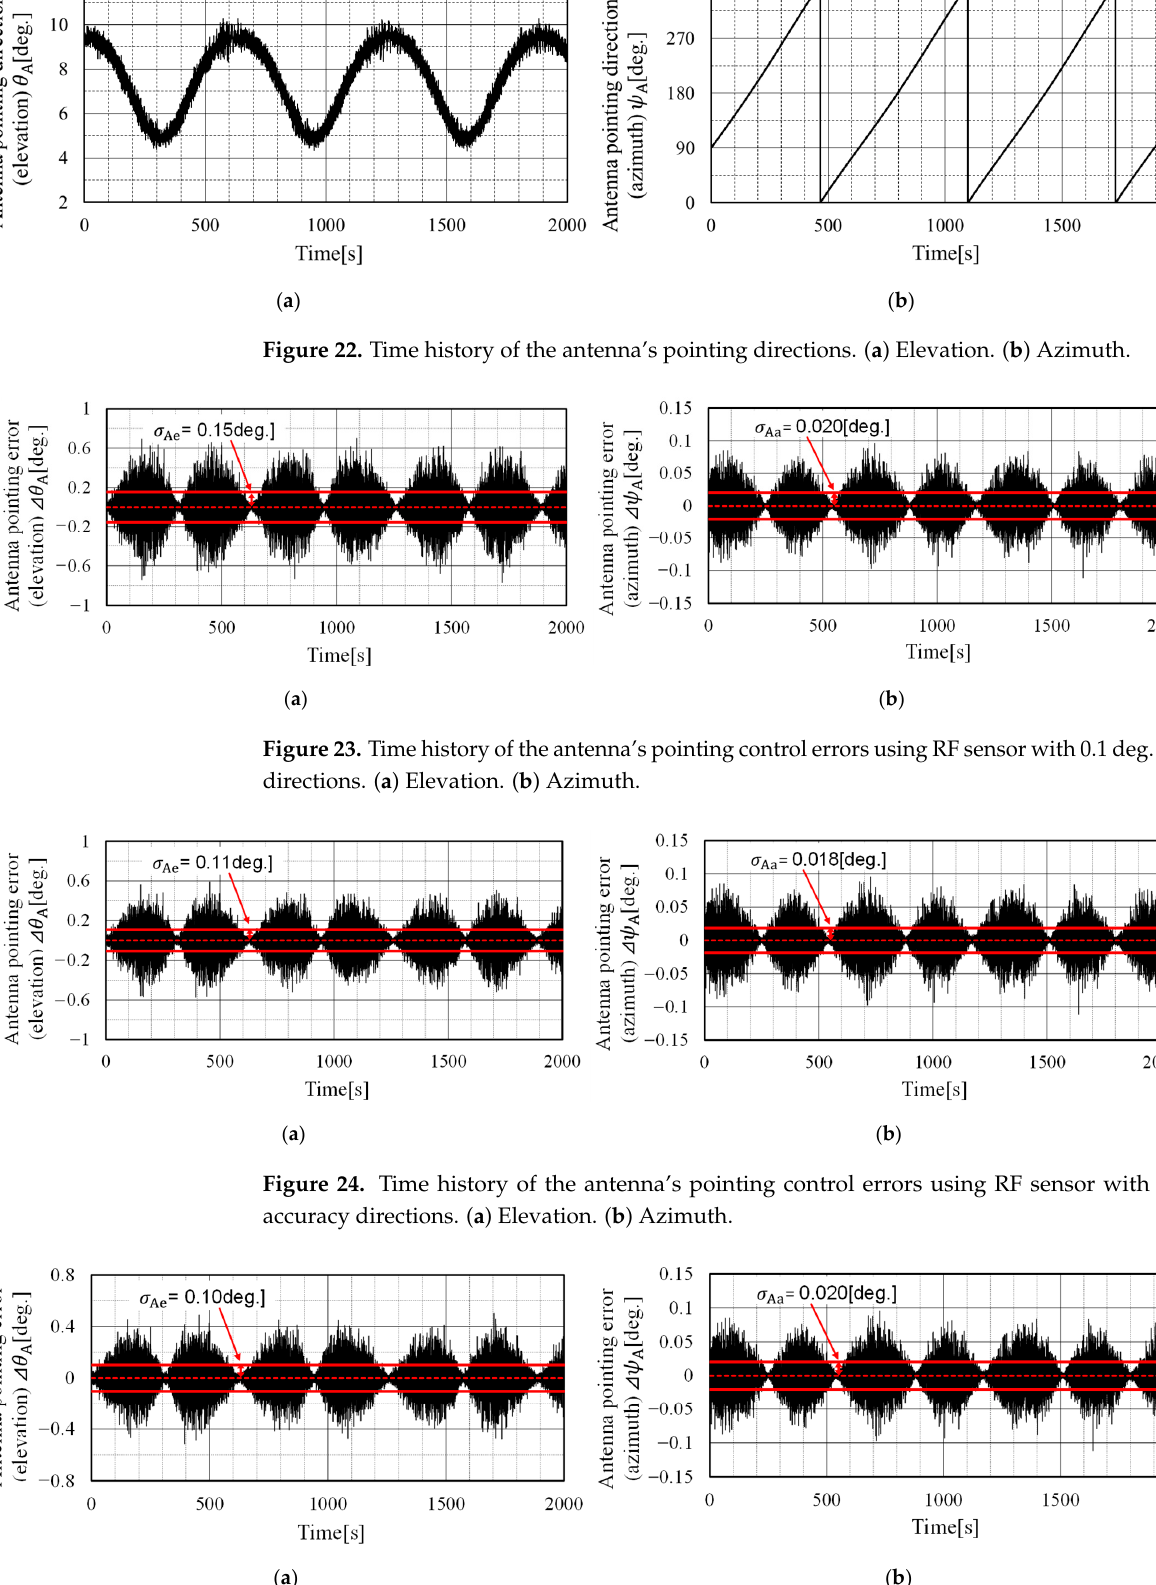
Figure 25. Time history of the antenna’s pointing control errors using RF sensor with 0.01 deg. ac- curacy directions. ( a ) Elevation. ( b ) Azimuth.